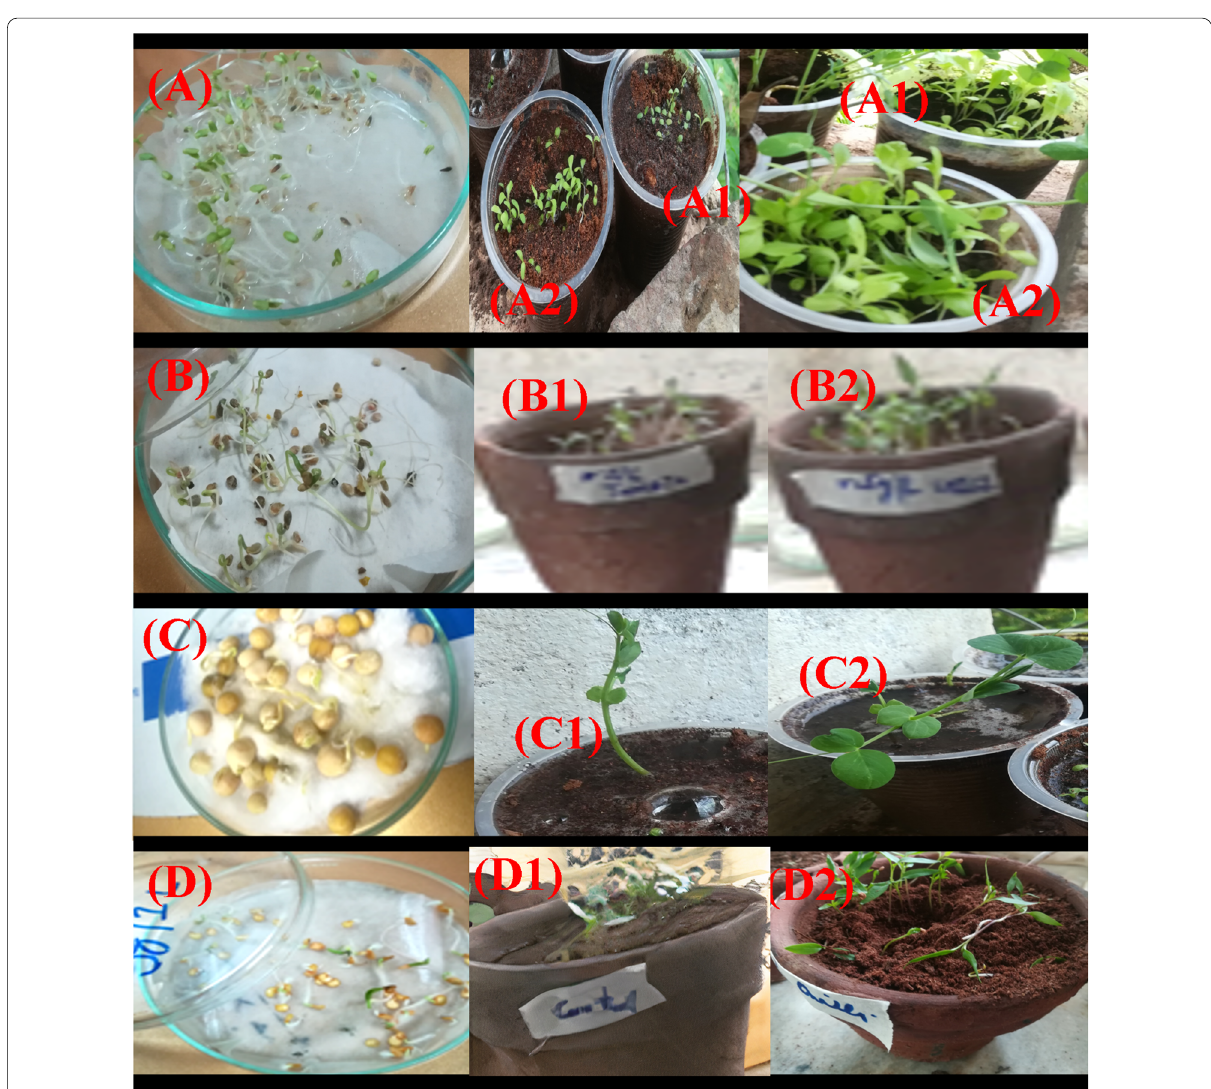
Fig. 5 Effect of crude lipopeptide extract on seed germination of A lettuce, B tomato, C beans, and D chili The portion ( A – D1 ) show untreated control plants and ( A – D2 ) for plants treated with lipopeptide extract at 0.7 g/mL for 40